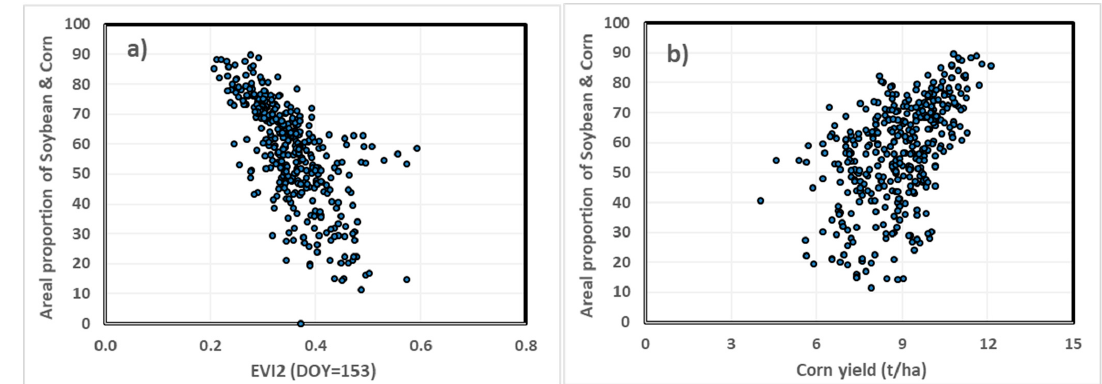
Figure 8. Relationships of county level areal proportions of corn and soybean combined with ( a ) EVI2 at day-of-year (DOY) 153 and ( b ) corn yield.